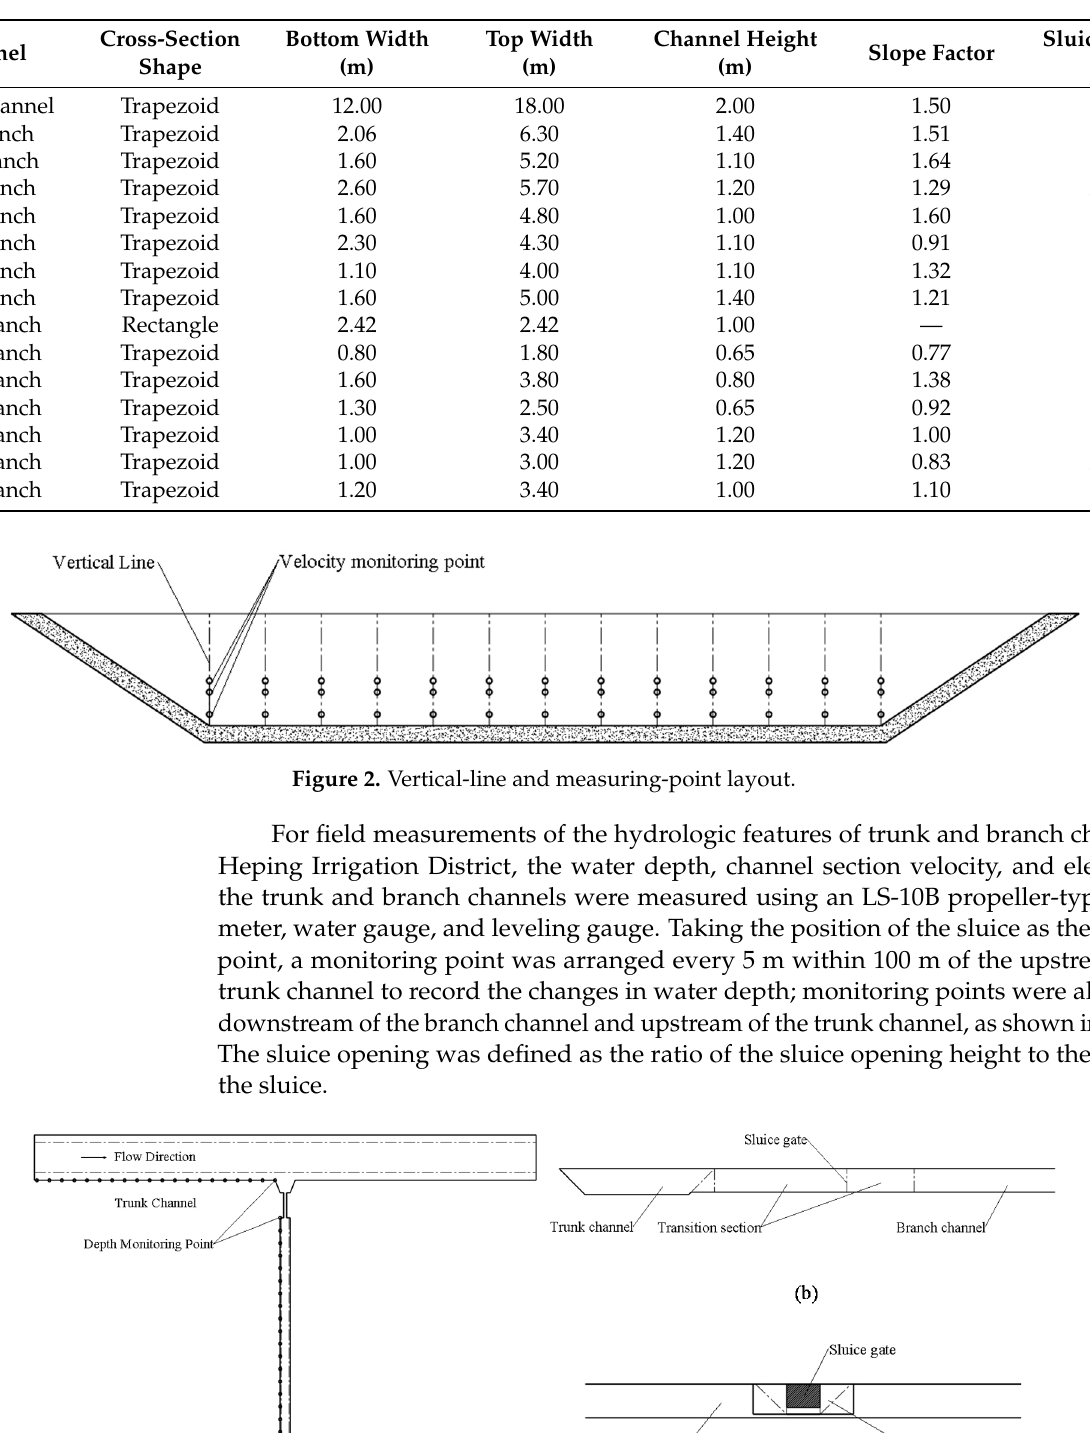
Table 1. Channel section structure and dimension information.